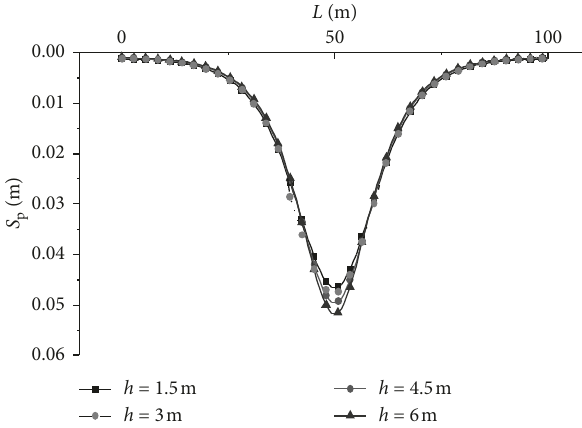
Figure 7: Transverse subsidence of pipeline in different embedment. Figure 5: Transverse subsidence of pipeline in different static